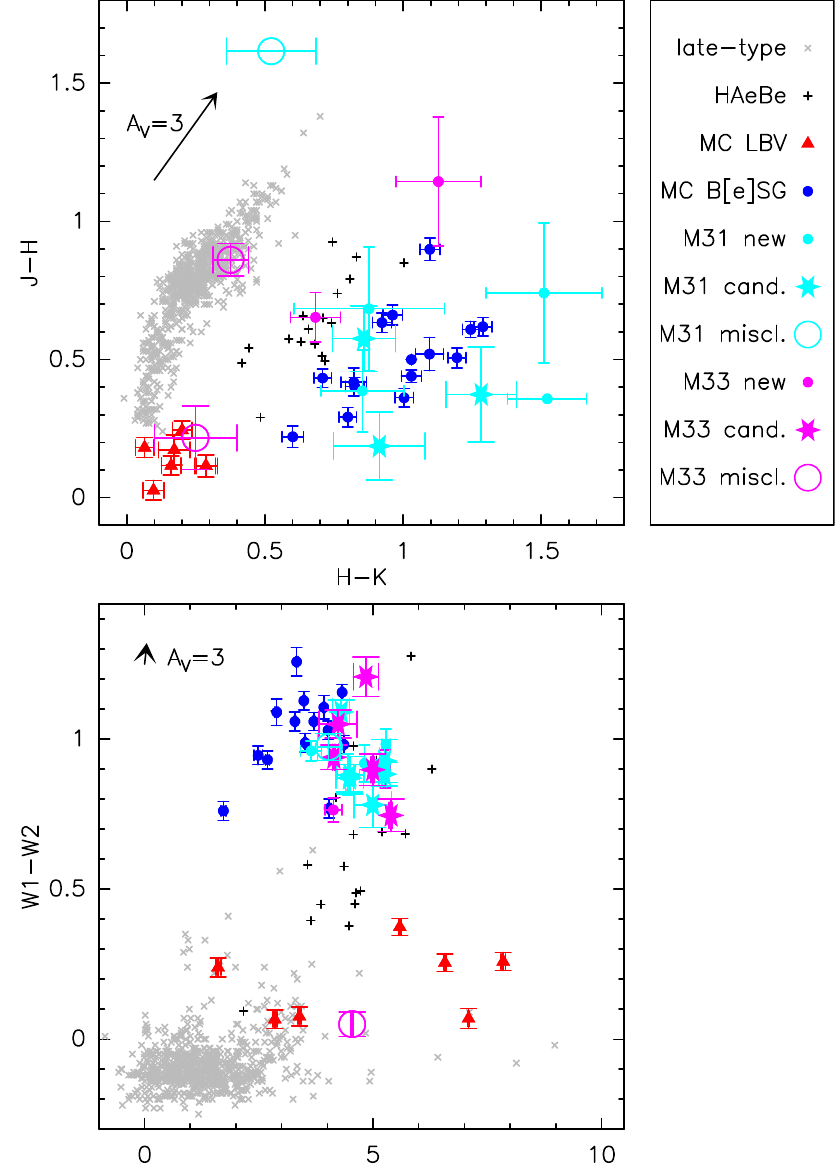
Figure 7. As Figure6 but for the location of the M31 (light blue) and M33 (purple) samples in the near-IR ( top ) and the WISE diagram ( bottom ) based on their observed colors. Typical values for the objects’ reddening are A V ≤ 1.5mag